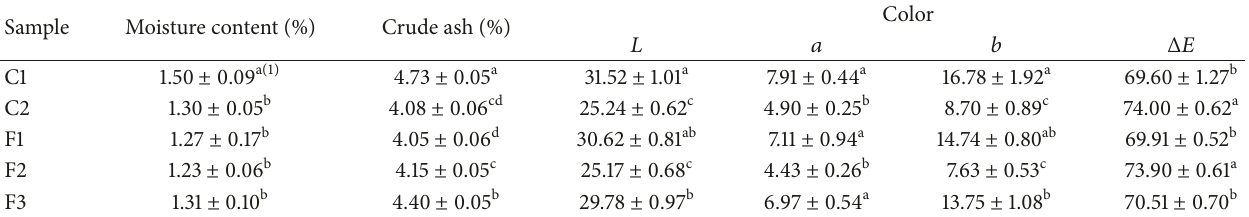
Table 2: Moisture content, crude ash, and color of ground roasted coffee beans after 24 h of yeast fermentation. Sample Moisture content (%)